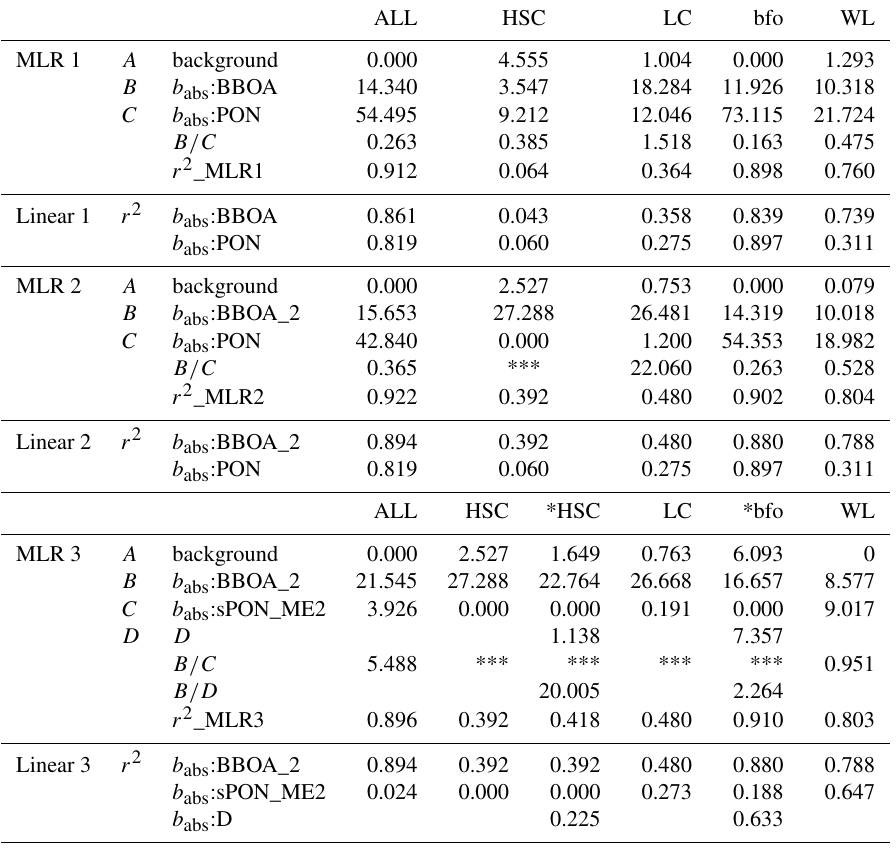
Table 1. Multilinear (MLR) and linear regression analysis between b abs_470wb and OAs. ALL HSC